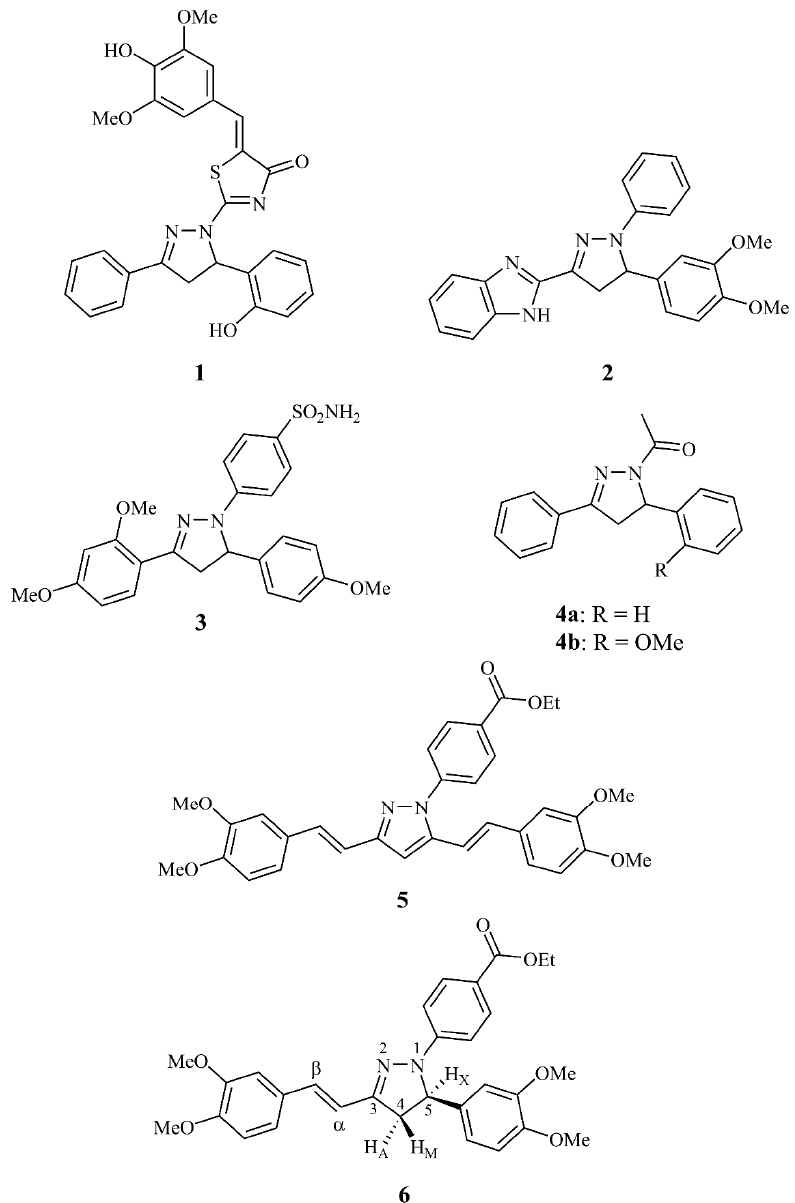
Figure 1. Structures of known biologically active pyrazolines 1 – 4 , pyrazole 5 and title pyrazoline 6 . The numbering of compound 6 skeleton is according to common pyrazoline nomenclature. The product 6 is racemic, however the relative configuration is shown for clarity and simplicity purposes to describe the AMX system and the